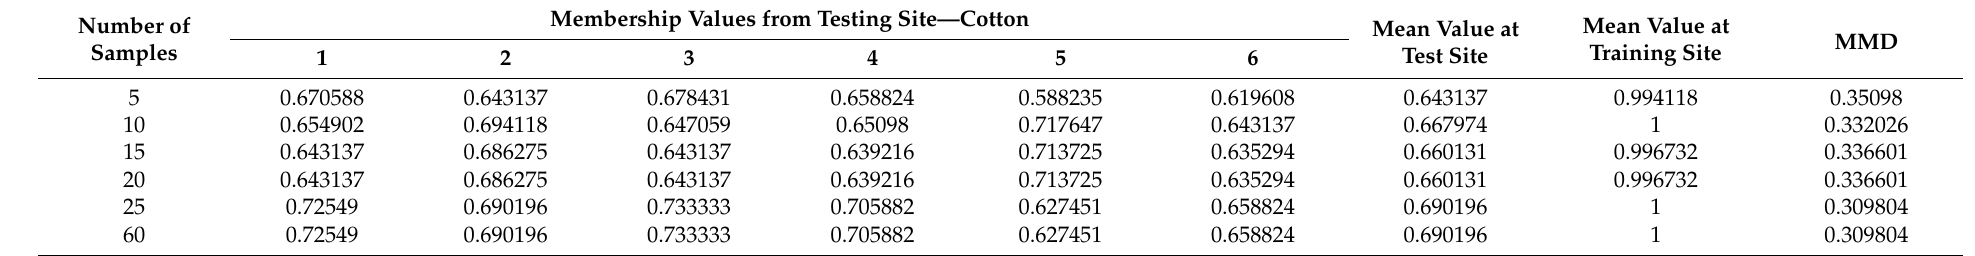
Table 12. Effect of increase in sample size by comparing membership values between Pigeon Pea Training fields and Cotton Test fields for separation—ISM training parameter based PCM